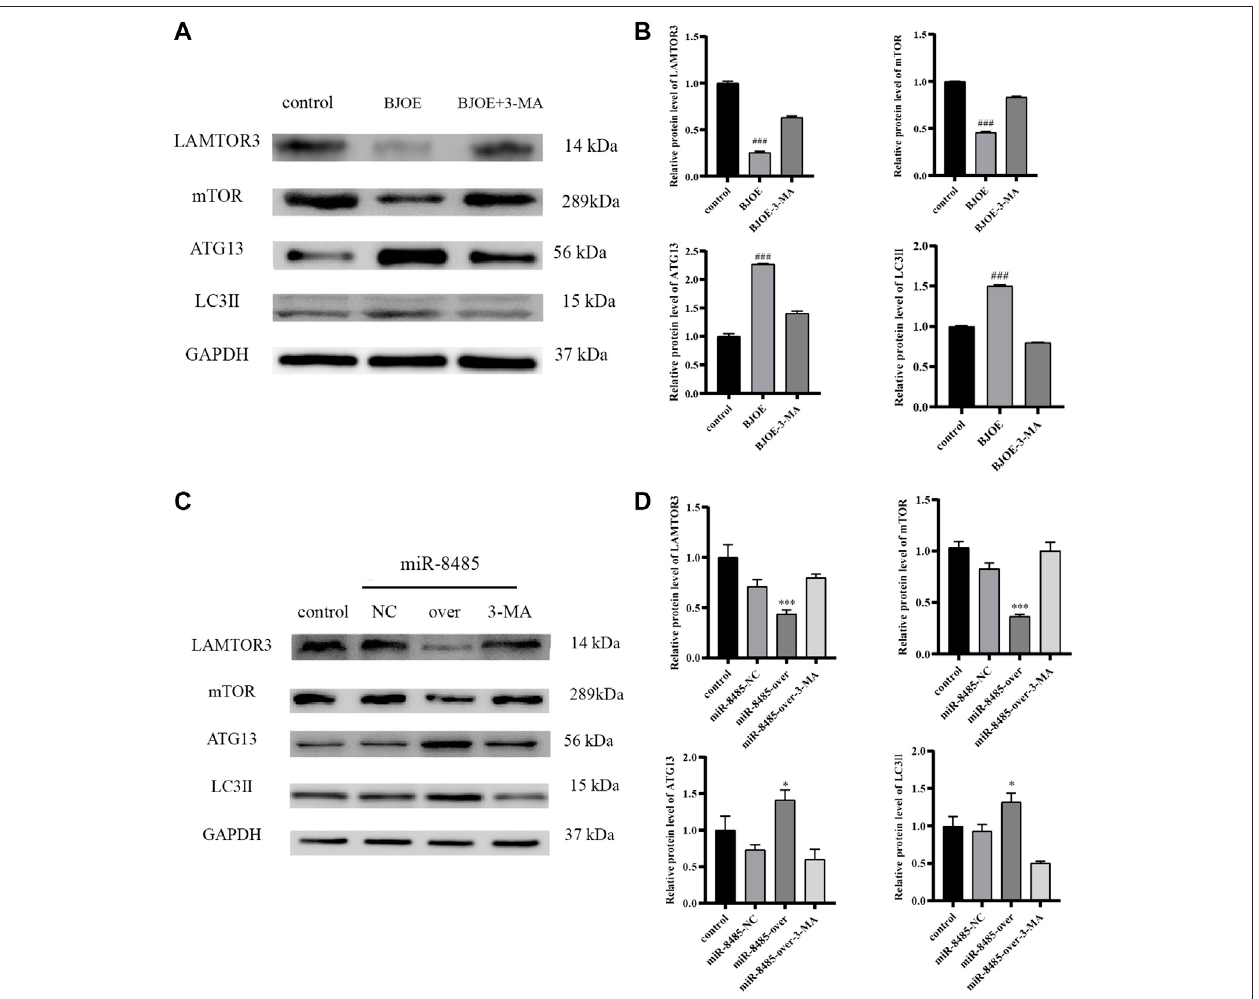
FIGURE 8 | Effects of BJOE and miR-8485 overexpression on autophagy-related gene proteins [ (A,B) Western blot analysis of protein expression of LAMTOR3, mTOR, ATG13 and LC3II incontrol group, BJOE and BJOE inhibitor group. (C,D) Western blot analysisofprotein expression ofLAMTOR3, mTOR, ATG13 and LC3II in control group, miR-8485 NC group, miR-8485 overexpression group and miR-8485 overexpression inhibitor group. All the p values were compared with the control group (n = 3). Data were shown as mean ± SD, ### p < 0.001; * p < 0.05, *** p < 0.001].